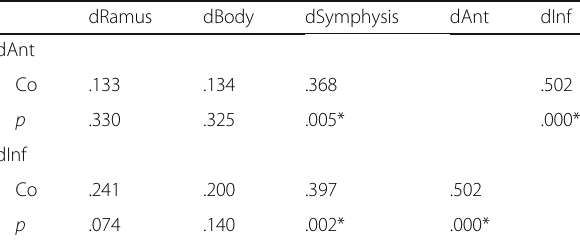
Table 6 Pearson ’ s correlation coefficiency in prognathic patients dRamus dBody